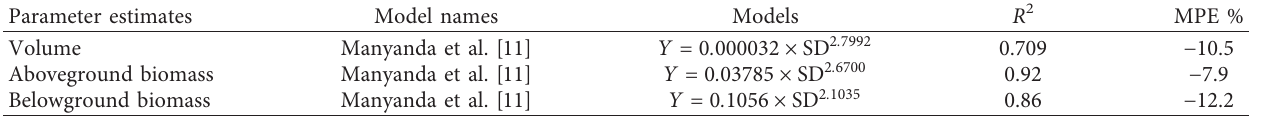
Table 1: Prediction models used for volume and biomass removal